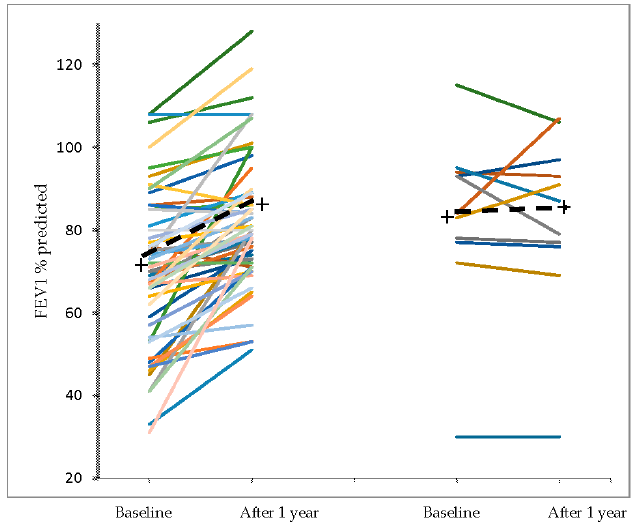
Figure 5. Individual values of the median annual FEV 1 (% of predicted) before and after vitamin D supplementation in adherent and non-adherent patients. The crosses and the dashed lines represent the mean change.